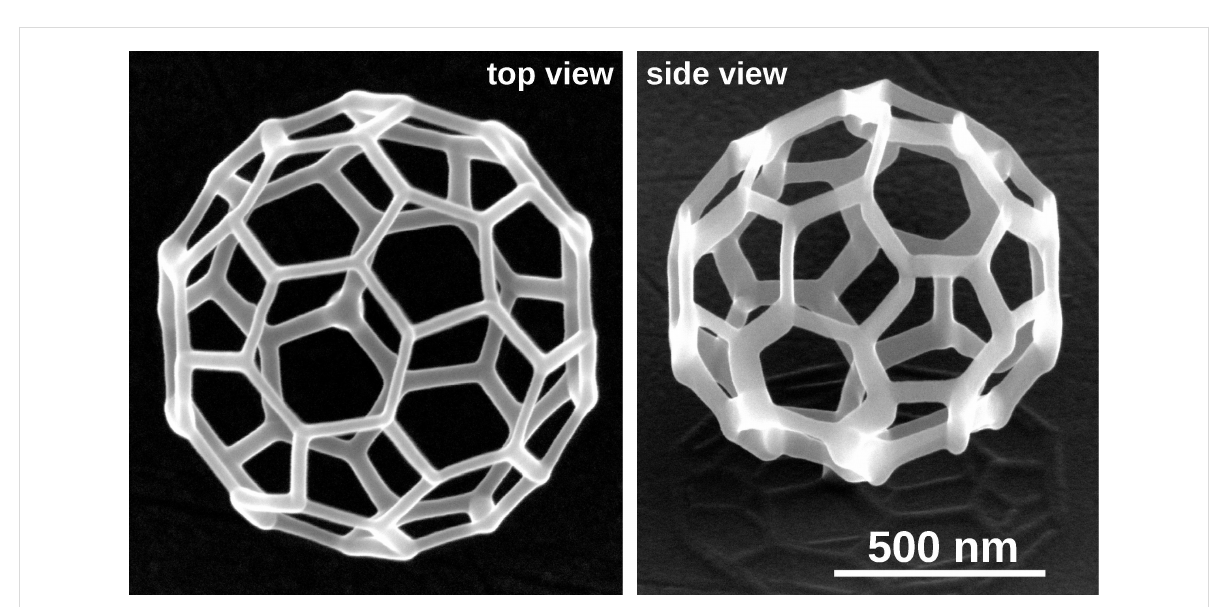
Figure 12: Buckyball structure in top and side view (52° tilted). Precursor: Me 3 CpMePt(IV), normal